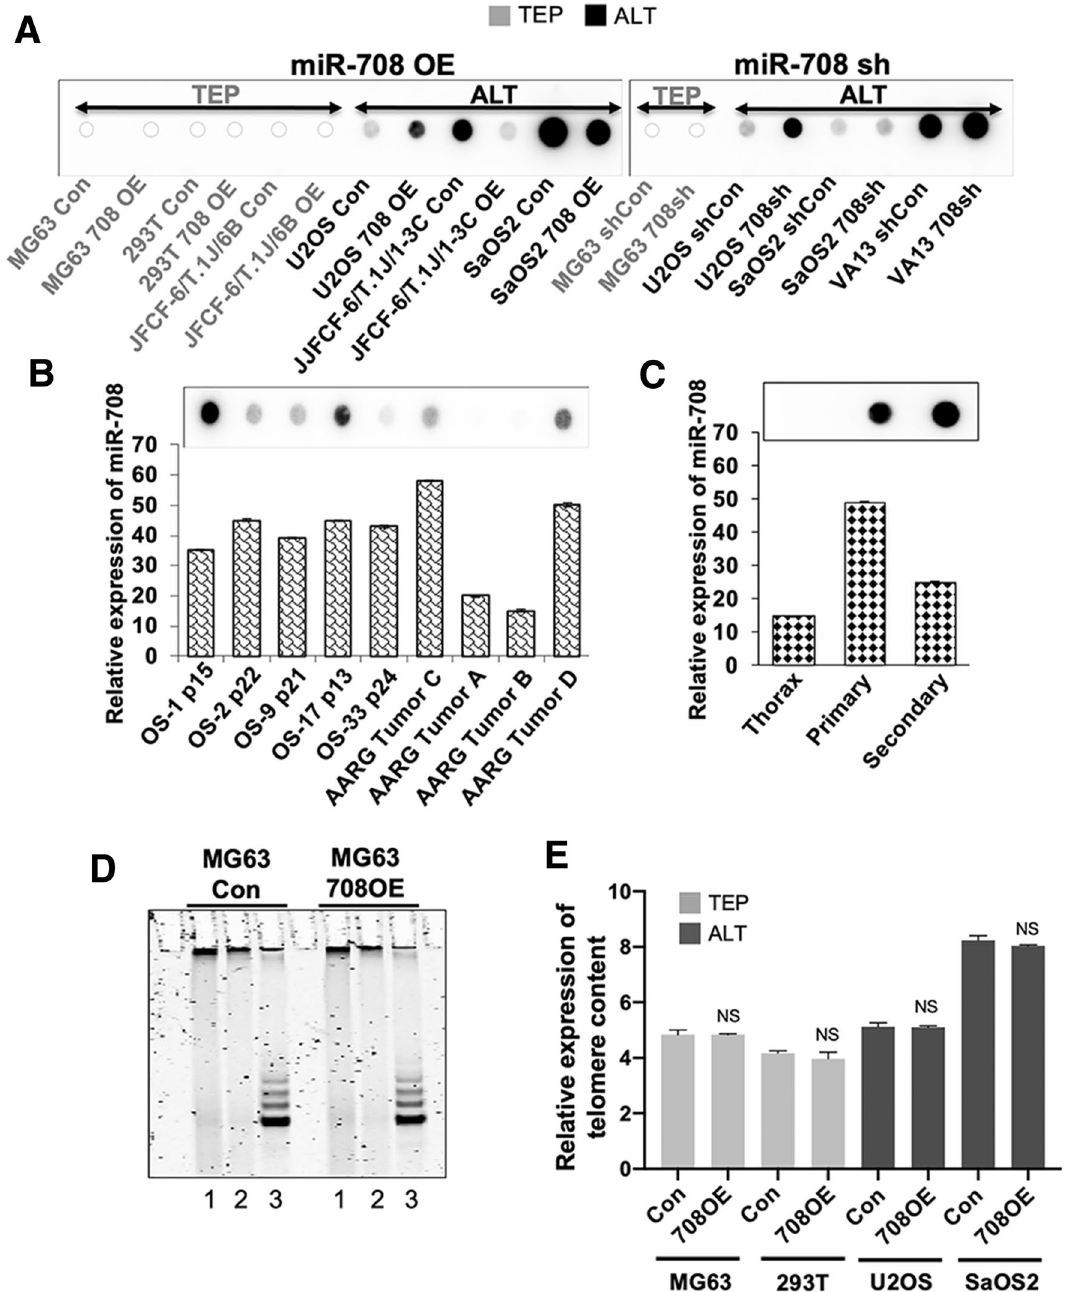
Figure 2. Effects of miR-708 on C-circles, telomerase activity and telomere length. ( A ) Slot blot analysis of C-circle content of miR-708-overexpressed (OE) and -deficient (sh) TEP and ALT cells, showing that miR-708 depletion increases C-circle content in 3/3 ALT cell lines and overexpression decreases C-circle content in 2/3 ALT cell lines. As expected, C-circles were not detected in TEP cell lines. ( B ) miR-708 expression in TEP and ALT osteosarcoma tumor samples. Top panel—Slot blot C-circle assay in pediatric patient derived xenografts (OS-1, OS-2, OS-9, OS-17 and OS-33) and adult osteosarcoma tumors (AARG). Lower panel—quantitation of miR-708 expression; data represent mean ± SD values compared within the group. ( C ) Top panel—Slot blot C-circle assay in normal thoracic tissue, and in primary and secondary tumors from a pediatric patient with osteosarcoma; lower panel—quantitation of miR-708 expression. ( D ) Telomerase activity as determined by the TRAP assay in control and miR708-overexpressed MG63 cells. Lane 1 shows water control, lanes 2 and 3 show TRAP assay with and without heat inactivation of telomerase, respectively. ( E ) Telomere qPCR was performed to determine content of telomeric DNA, expressed in arbitrary units (a. u.) in miR-708-overexpressed TEP and ALT cells. NS: not significant when comparing control and miR-708-overexpressed cells. Con: control for miR- 708 expression; 708OE: miR-708 expression; shCon: control for miR-708 knock-down; 708sh: miR-708 knock- down using short-hairpin interfering RNA. NS =>